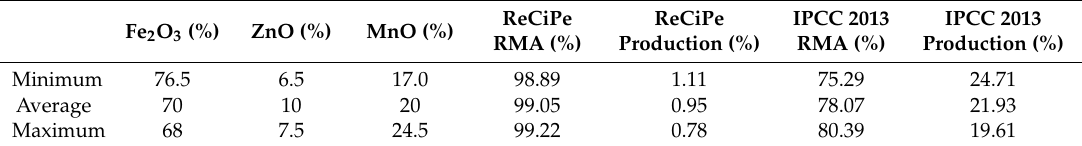
Table 10. RMA and production percentages for minimum, maximum, and average MnZn soft ferrites.